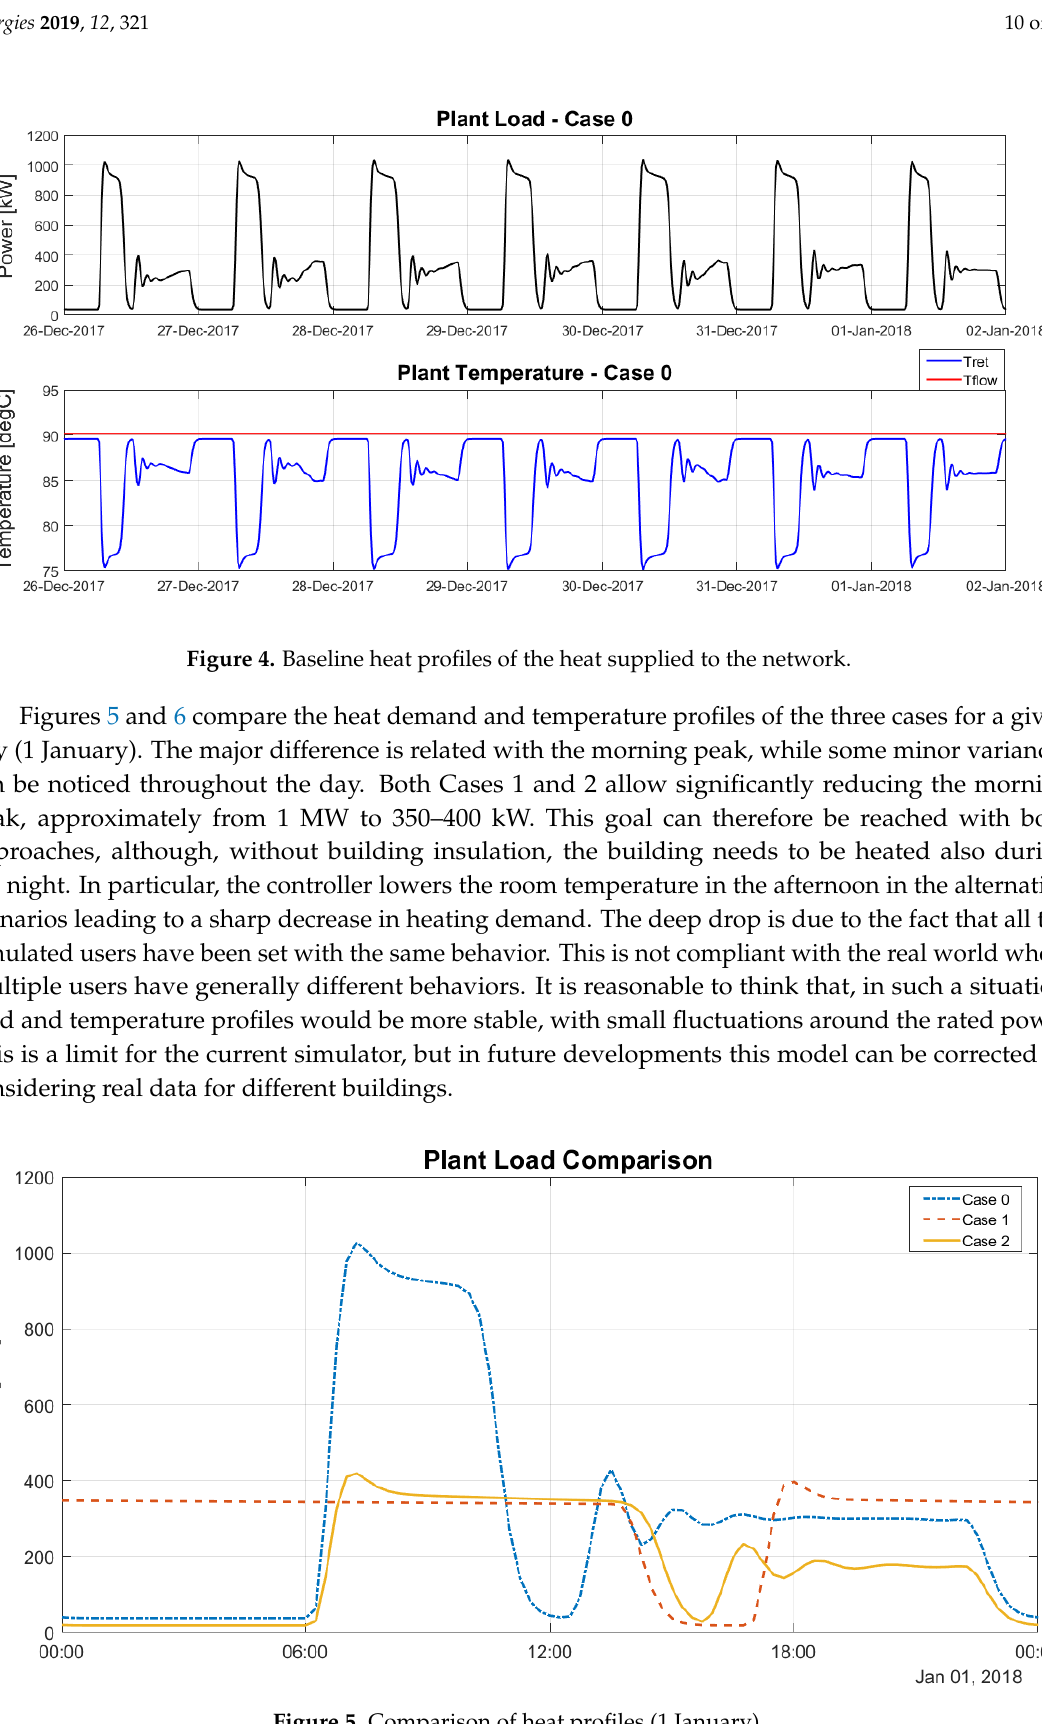
Figure 5. Comparison of heat profiles (1